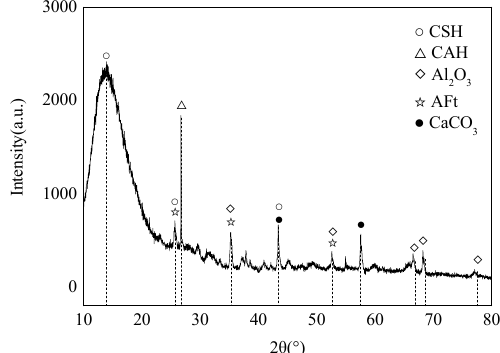
Figure 8. XRD pattern of E1 samples.